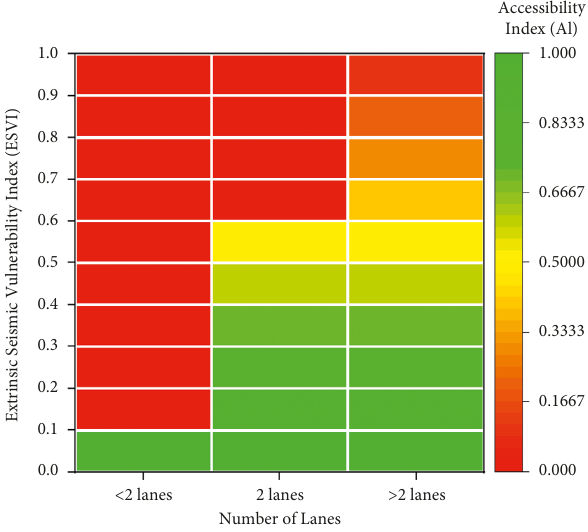
Figure 19: Generated accessibility heat map between integrated road characteristics and integrated seismic vulnerability index for NEVs.